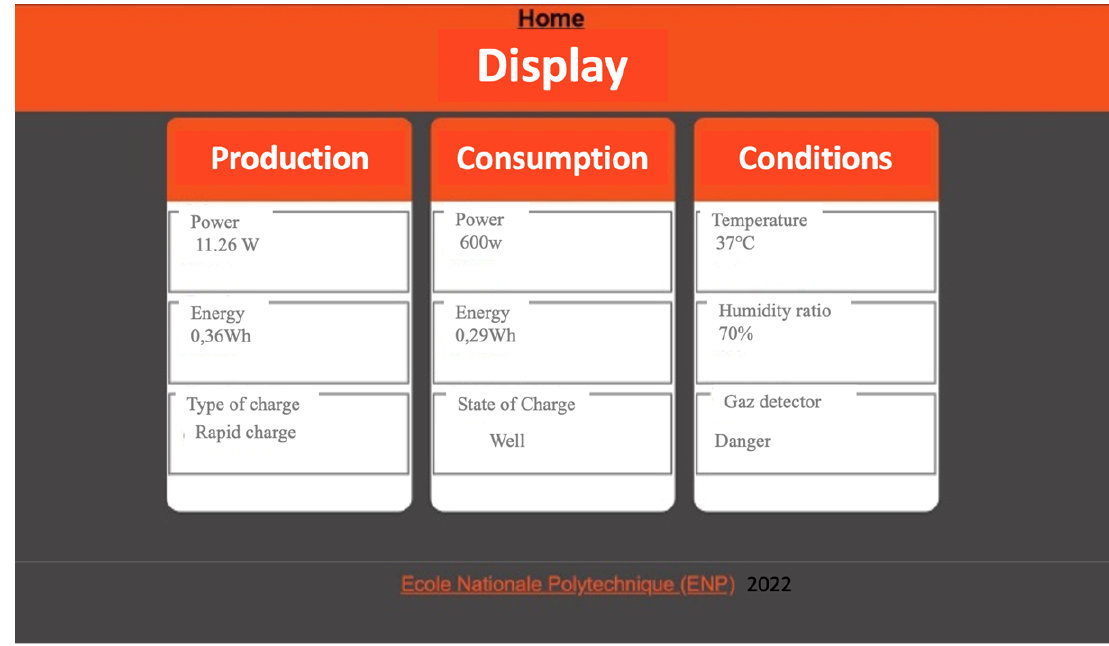
Figure 8. Interface Display.